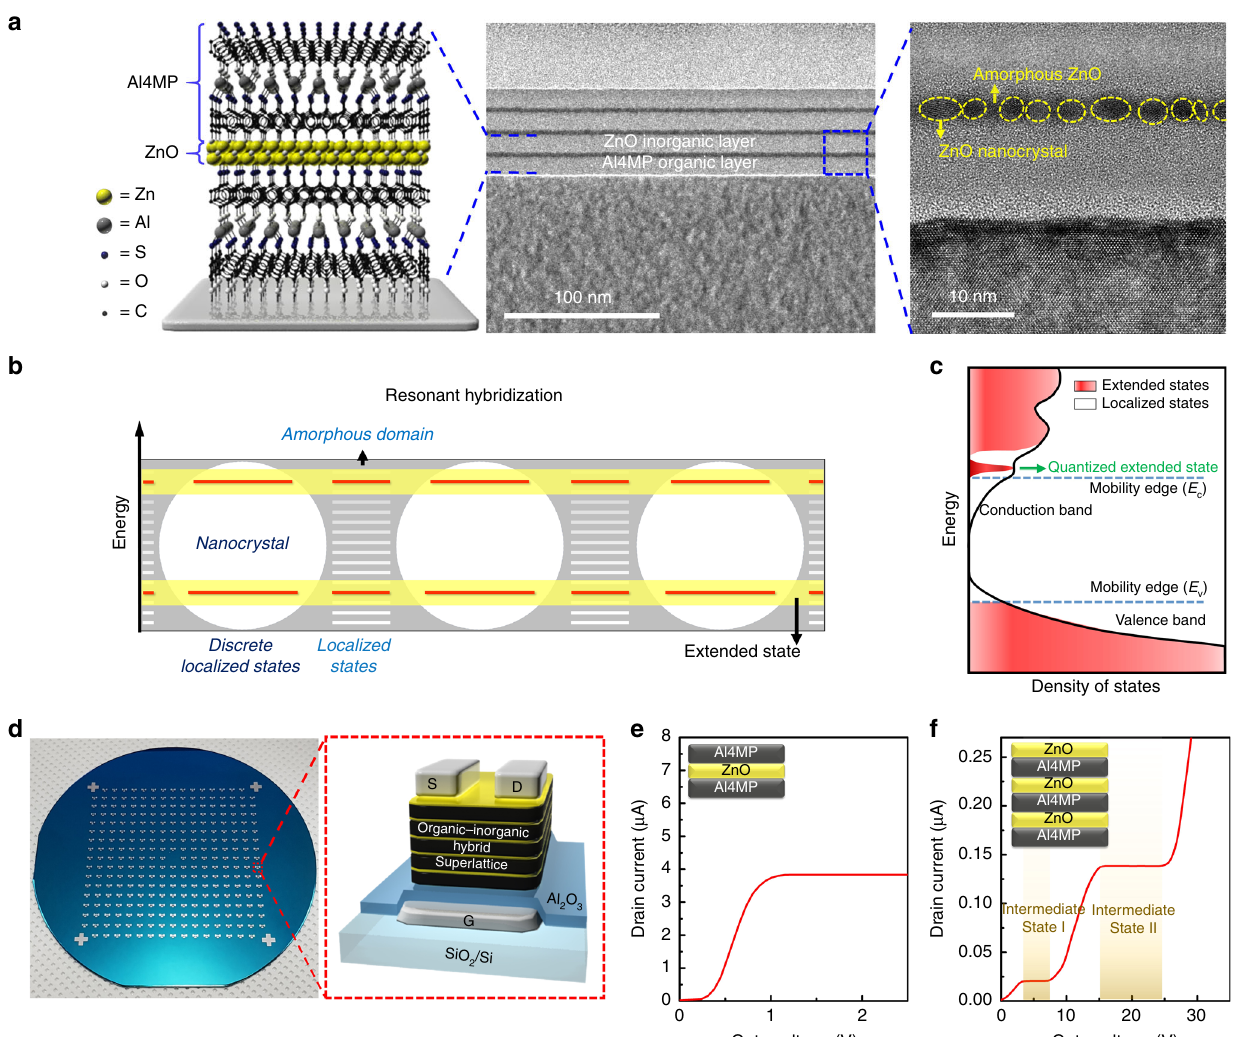
Fig. 1 Zinc oxide (ZnO) composite nanolayer with mobility edge quantization through resonant hybridization. a Schematic image of an organic-inorganic hybrid superlattice thin fi lm. Cross-sectional transmission electron microscopic (TEM) images of the hybrid superlattice and the ZnO nanolayer in the superlattice. Yellow circles with dotted lines along the ZnO nanolayer represent ZnO quantum dots (QDs). b Schematic illustration of resonant hybridization of quantized energy levels of ZnO QDs with localized levels of amorphous ZnO for the composite ZnO nanolayer. c Schematic diagram of the total density of states for the composite ZnO nanolayer in the hybrid superlattice. d Photograph of the integrated multi-value logic transistor arrays on 4-inch Si wafers with 300-nm thick SiO 2 . The schematic structure in the right red box is a unit transistor containing the hybrid superlattice thin fi lms e Linear-scale transfer characteristics of a binary transistor with a single ZnO nanolayer in quantum well structures. A schematic of the structure of an active layer in the transistor is provided in the image inset. f Linear-scale transfer characteristics of a quaternary transistor with the triple ZnO nanolayers. A schematic of the structure of the active layer in the transistor is provided in the image